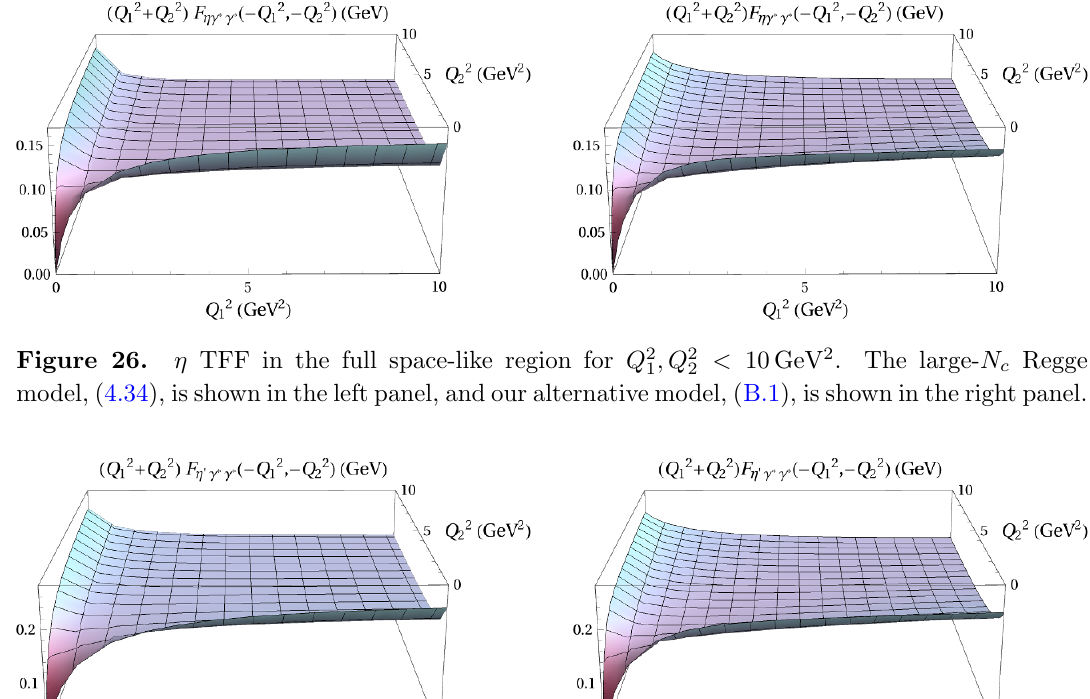
Figure 27. (cid:17) 0 TFF in the full space-like region for Q 2 model, (4.34), is shown in the left panel, and our alternative model, (B.1), is shown in the right